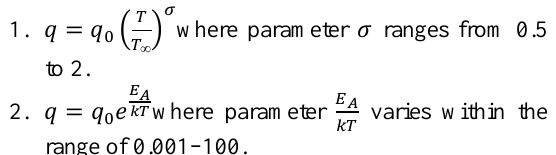
Fig.3. Distribution of